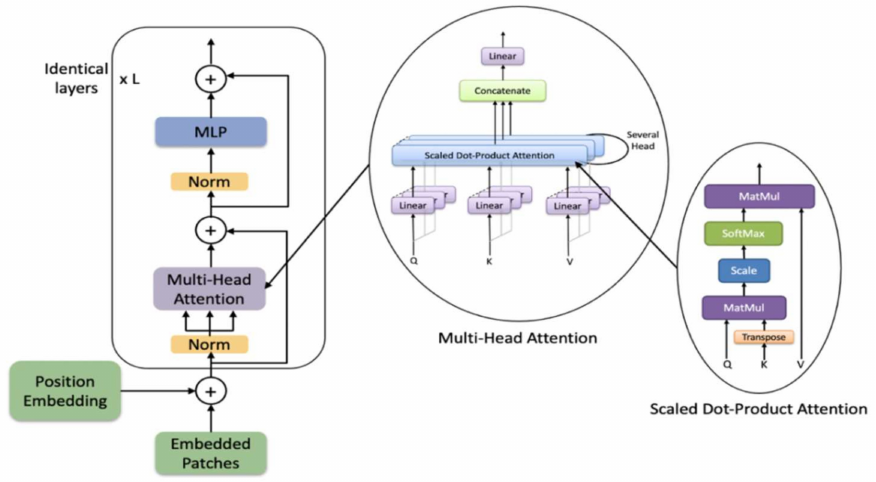
Figure 3. The architecture of the transformer encoder.